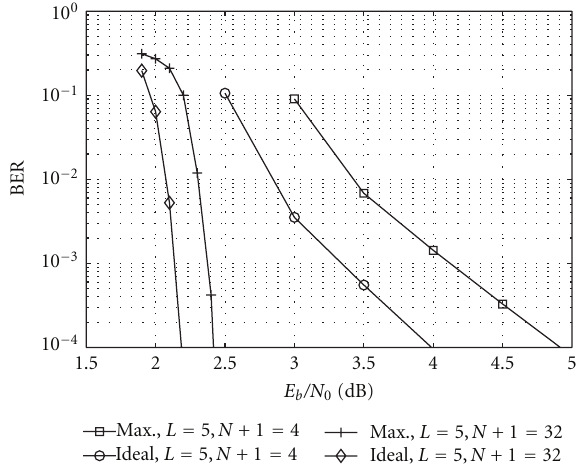
Figure 11: Bit-error performance with dominant subtrellis approach for di ff erent values N and L = 5